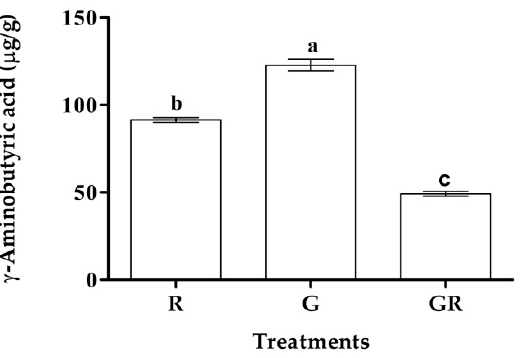
Figure 2. The GABA contents of red-pigmented rice in raw (R), germinated (G), and germinated and roasted (GR) conditions. Values expressed as means ± SD ( n = 3).